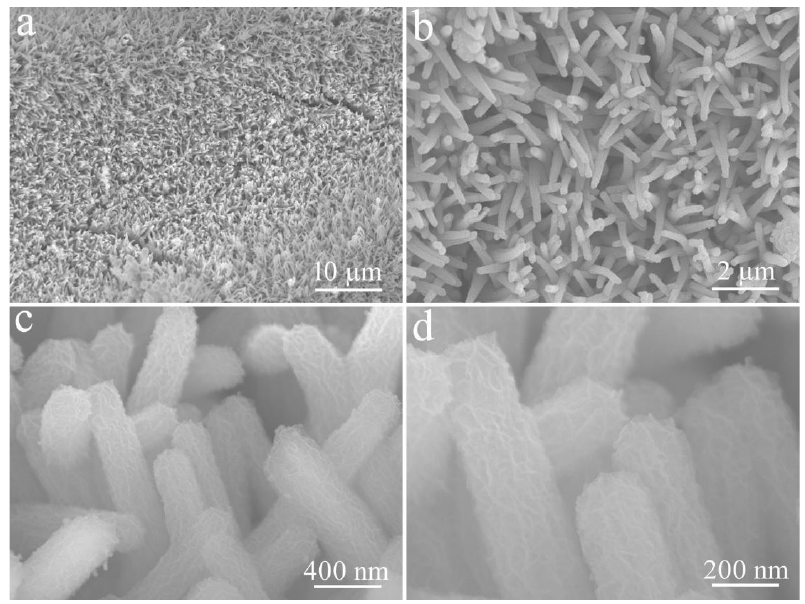
Figure 3. ( a , b ) Low-magnification and ( c , d ) high-magnification FE-SEM images of Cu(OH) 2 /Ni 3 S 2 composite.